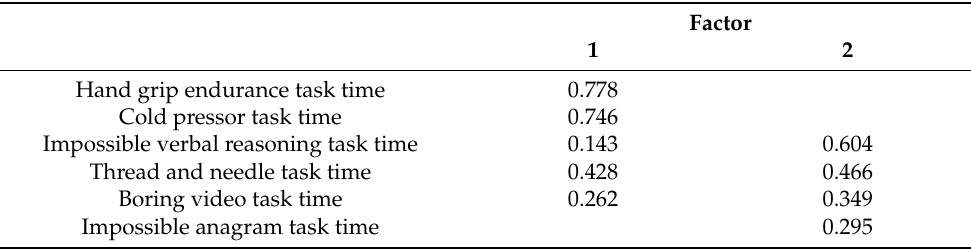
Table 2. Loadings for rotated factor matrix: extraction by Maximum Likelihood method. Factor 1 could be described as “physical BP” and factor 2 could be described as “mental BP”.